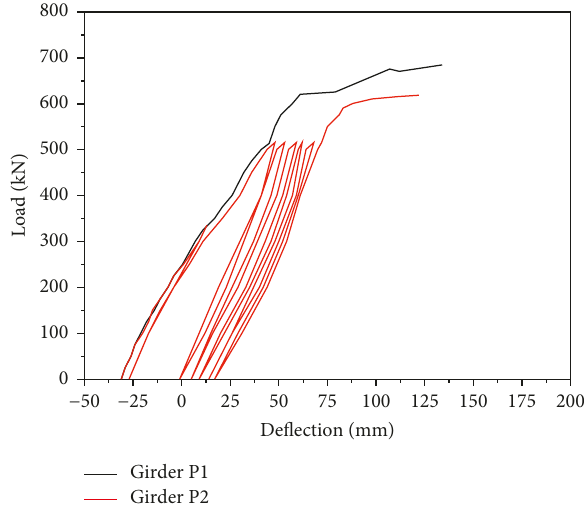
Figure 19: Load–net deflection curves for girder P2 under repeated